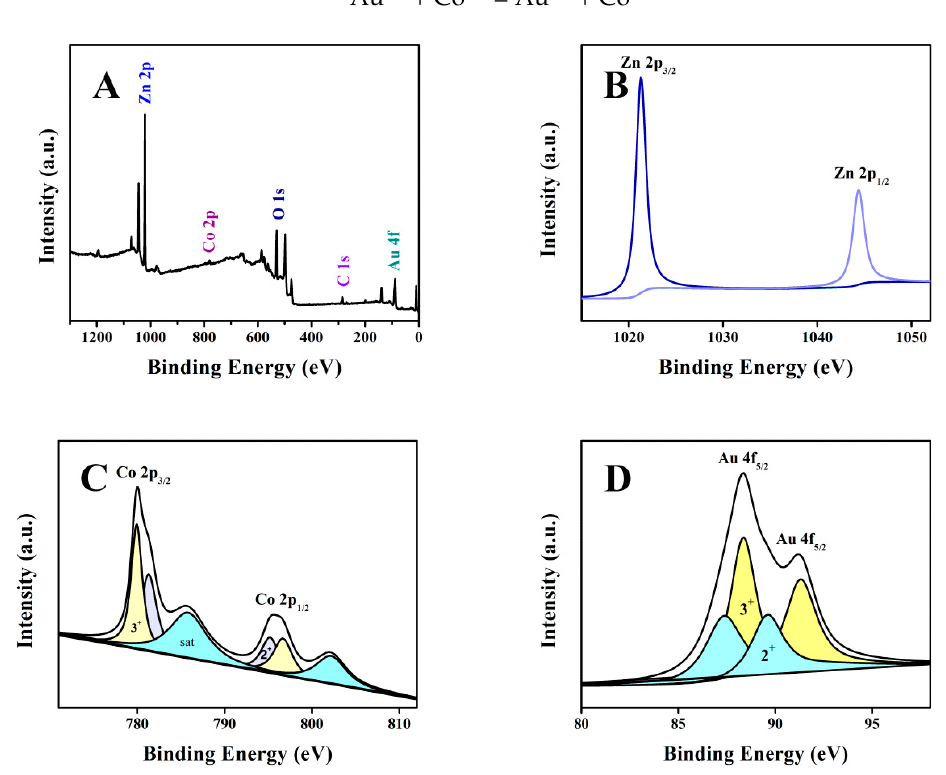
Figure 5. XPS spectra of ( A ) XPS survey spectrum of Co 400 -ZnO/Au, ( B ) Zn 2p, ( C ) Co 2p, and ( D ) Au 4f for Co 400 -ZnO/Au. ( D ) Au 4f for Co 400